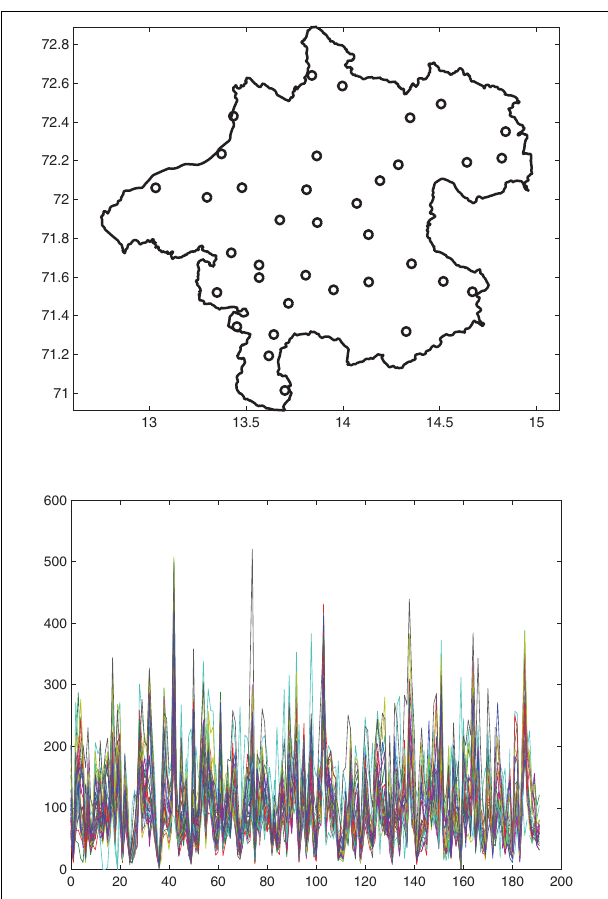
FIGURE 2 | Above: The 36 sampling locations of the Upper Austria rainfall data set set. Below: The 36 time series of average monthly rainfall at each station. FIGURE 3 | Above: The average monthly rainfall over the years at each of the